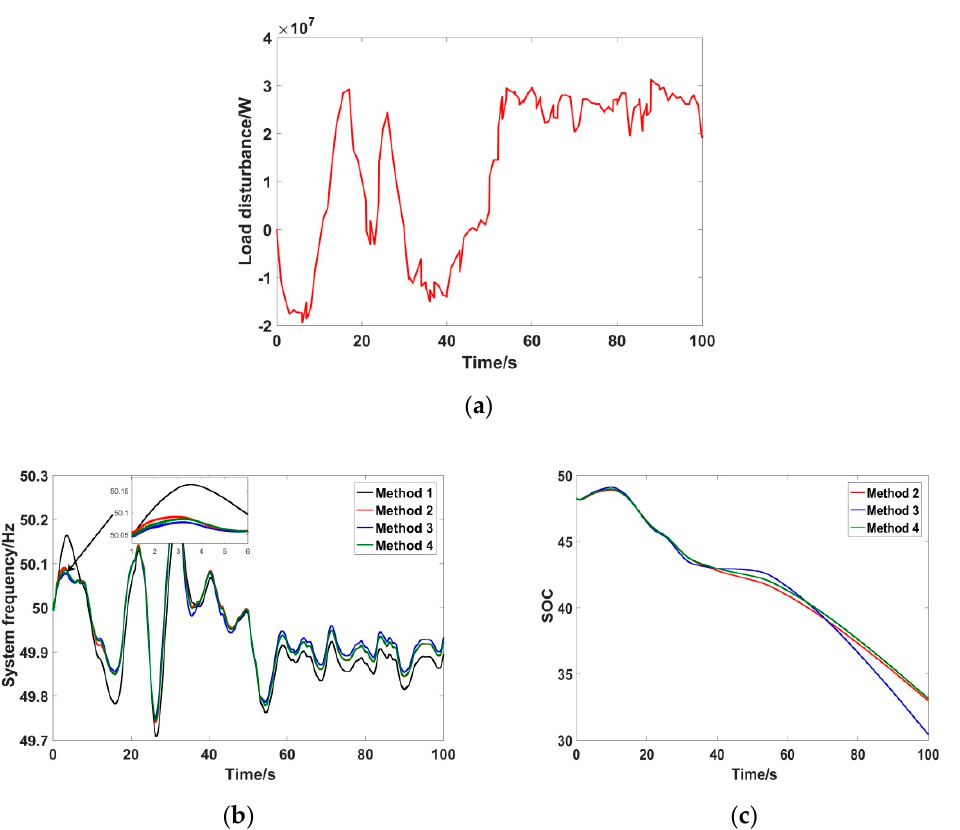
Figure 21. Results of continuous load disturbance (Load B). ( a ) Continuous load disturbance curve. ( b ) System frequency curves under continuous load disturbance. ( c ) SOC curves of the energy storage system.